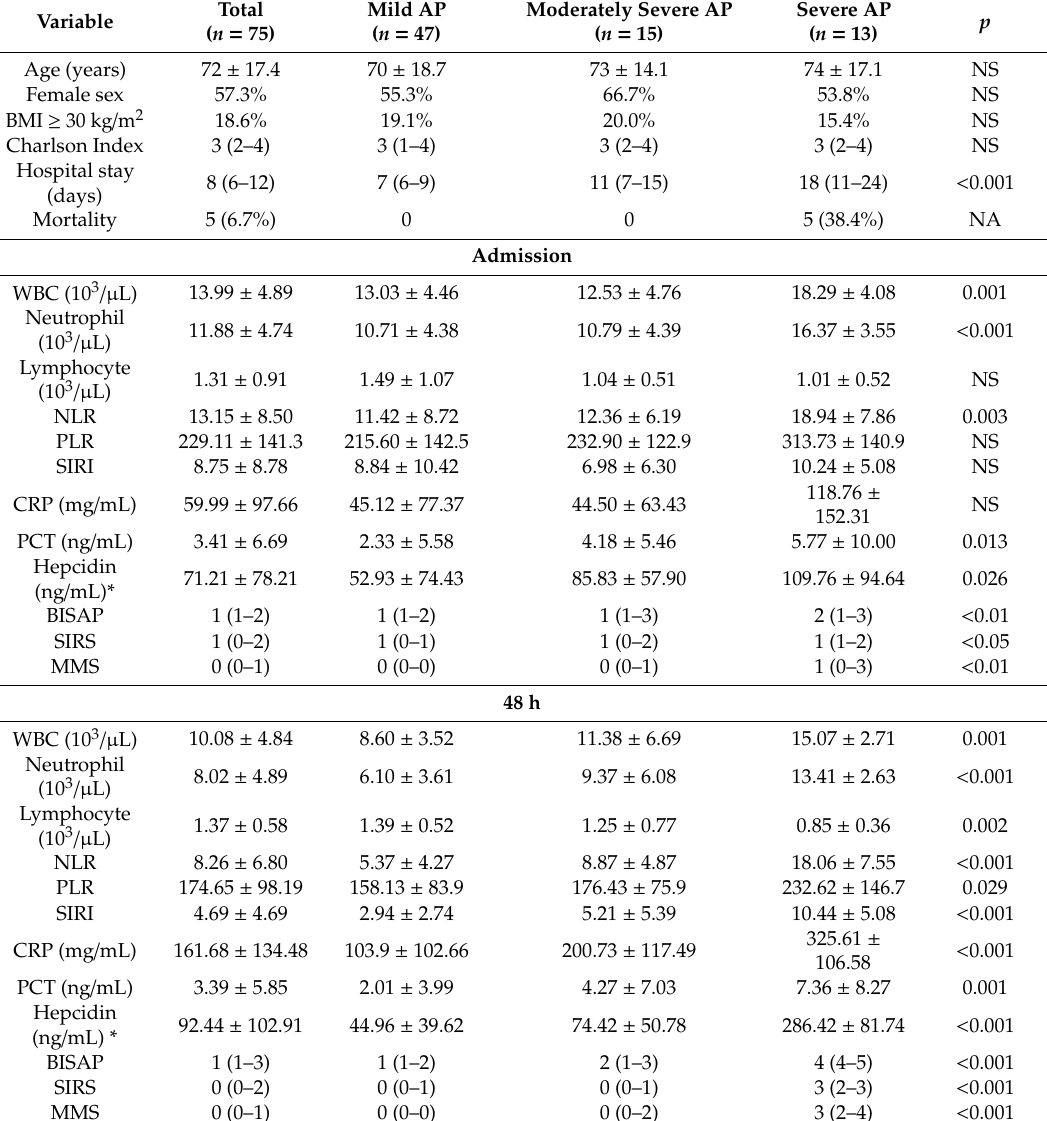
Table 1. Baseline characteristics of the patients with acute biliary pancreatitis in the di ff erent severity